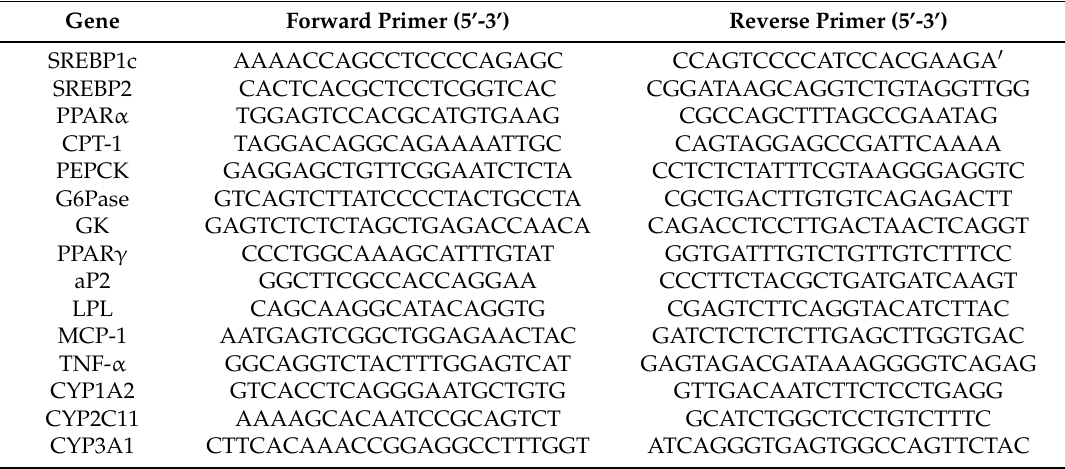
Table 3. Sequences of primers used for real-time quantitative PCR